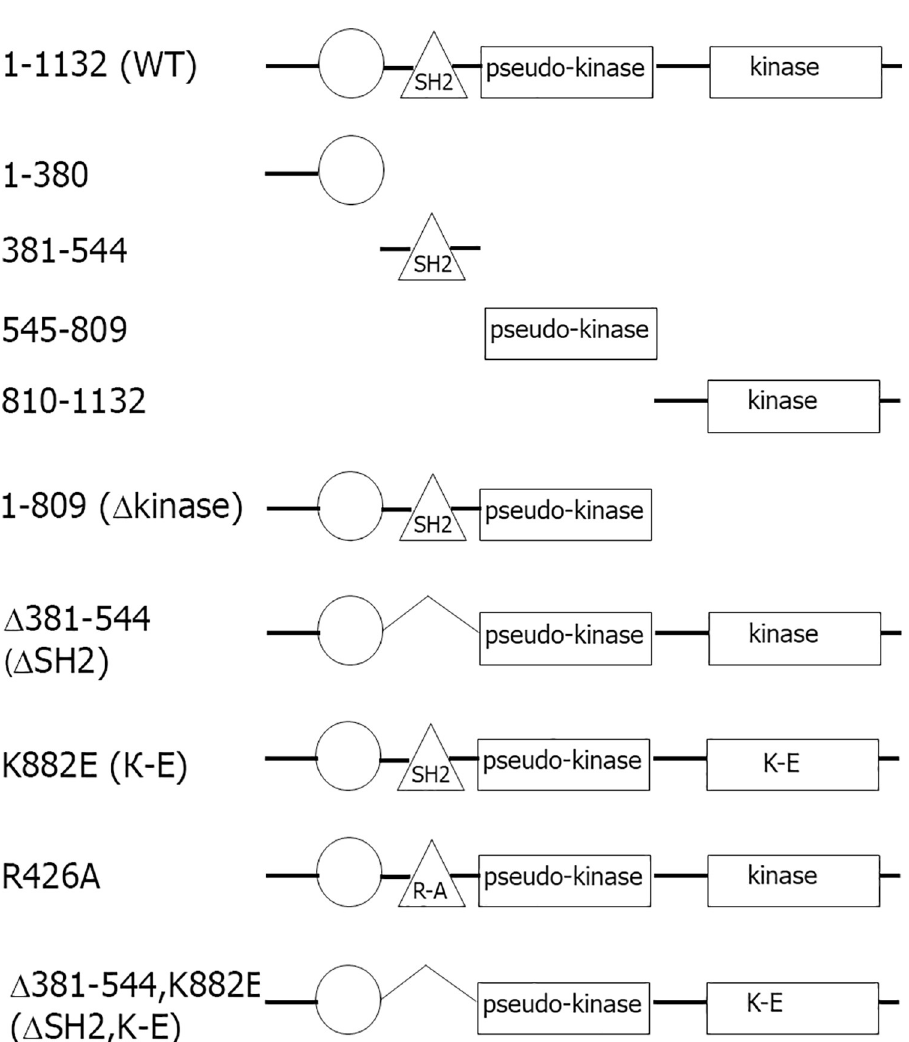
Fig 1. Schematic representation of wild type and mutant forms of mouse JAK2 used in this study. Circle represents FERM domain (AA 37–380). The triangle represents an SH2 domain (AA 401–482) and the rectangles represents pseudo-kinase (AA 545–809) and kinase (AA 849–1124) domains. sequencing and their sizes and expression were confirmed by Western blotting. We transiently transfected the WT and the truncated mutants of EGFP-tagged JAK2 in COS-7 cells. The cells were also immunolabelled for centrin-1 to identify both centrioles. As expected, endogenous JAK2, detected by anti-JAK2 (green in Fig 2A ), localized to one centriole labeled with anti- centrin-1 (red in Fig 2A , merge image). When WT JAK2 fused with EGFP was transiently expressed in COS-7 cells, it localized to the centrosome ( Fig 2B ) in contrast to the localization of EGFP protein, which was diffuse throughout the cytoplasm ( Fig 2C ). It is noteworthy that, unlike endogenous protein, exogenously expressed JAK2 demonstrated a tendency to localize to both centrioles. The same phenomenon was described earlier for the centrosomal protein CEP19 [37]. When we overexpressed truncated mutants of JAK2, both the SH2-domain-con- taining mutant (381–544) ( Fig 2E ) and the kinase-domain-containing mutant (810–1132) ( Fig 2G ) demonstrated centrosomal localization of these constructs, while FERM-domain- containing (1–380) ( Fig 2D ) and pseudo-kinase domain (545–809) ( Fig 2F ) distributed